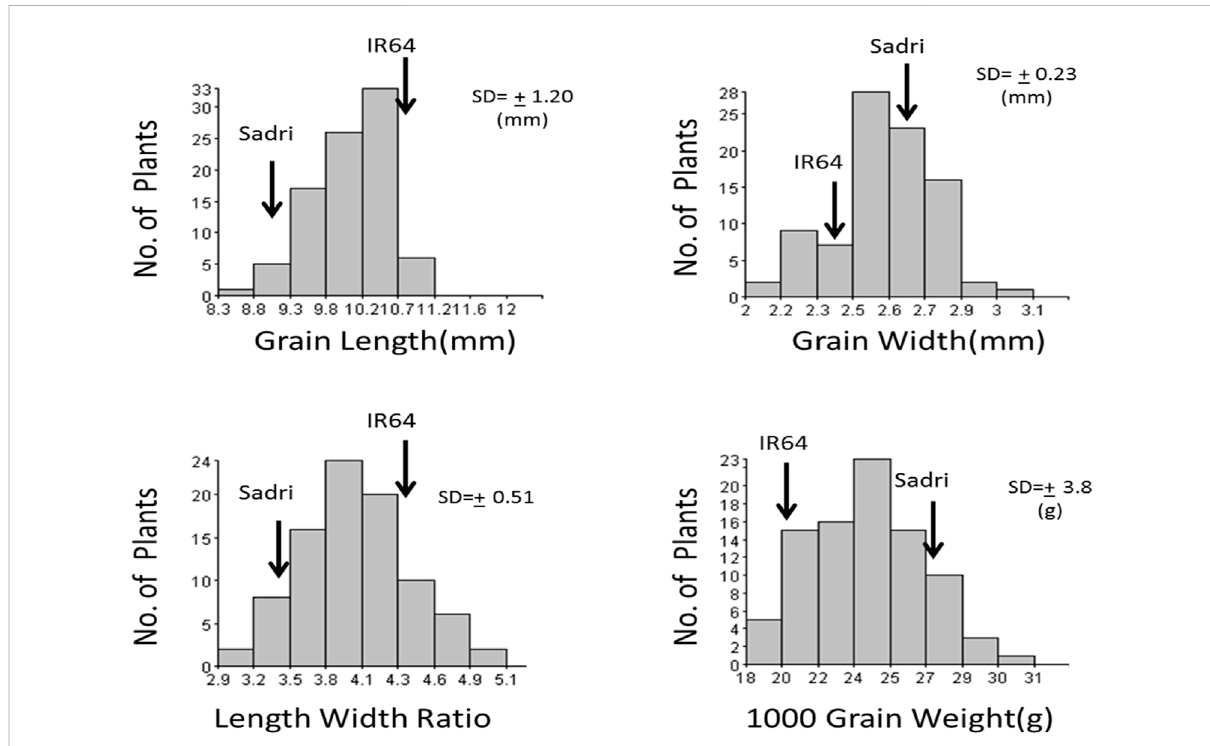
FIGURE 1 Frequency distribution of grain size, grain shape, and grain weight in F 2